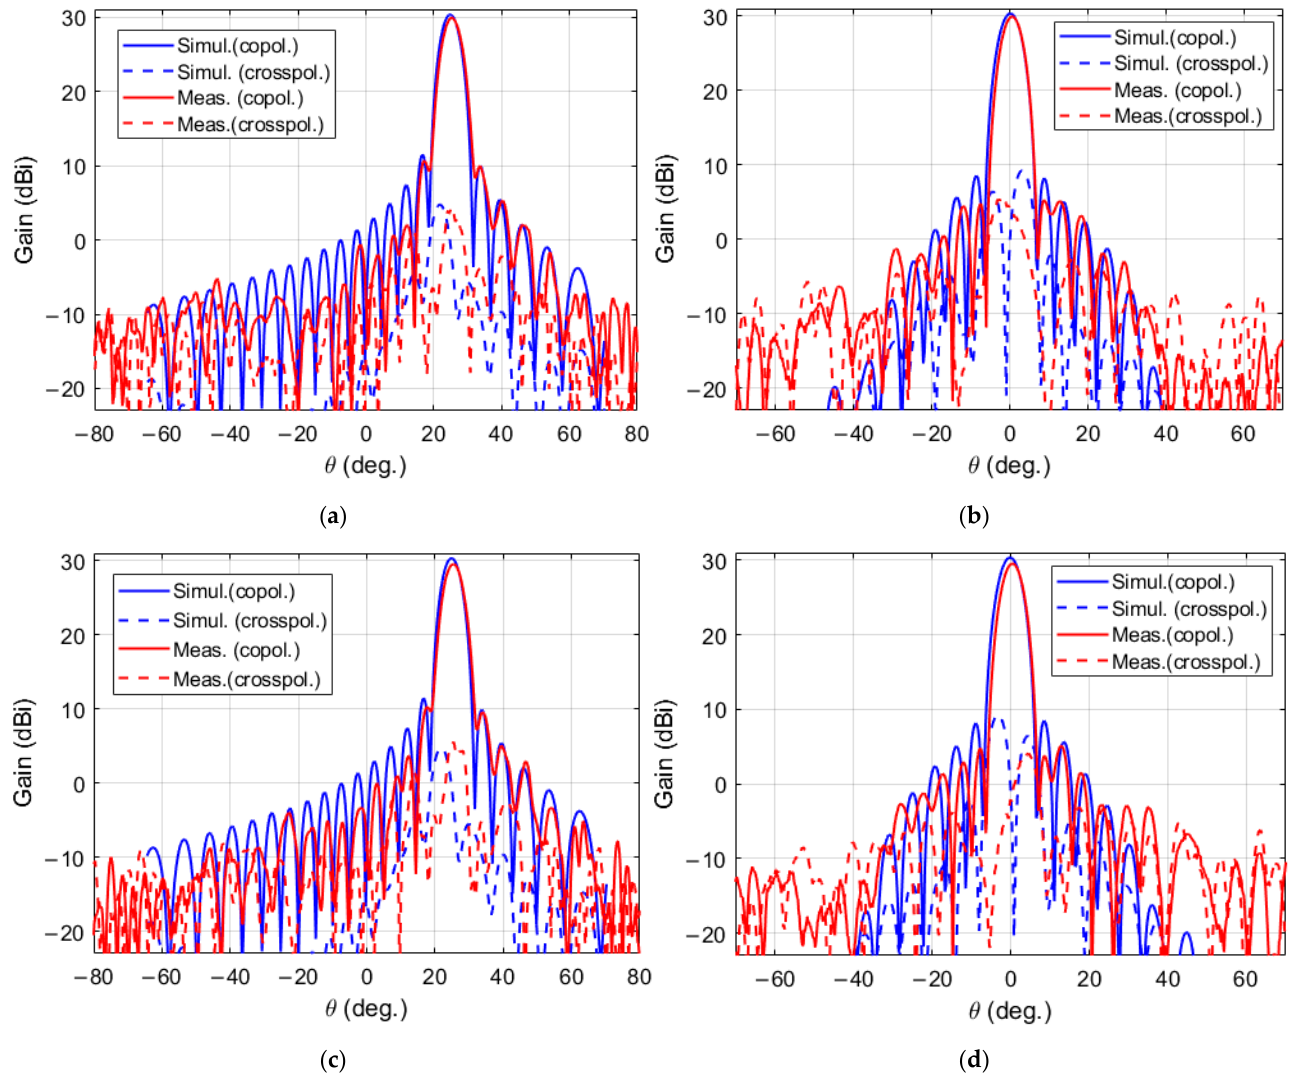
Figure 8. Comparison of simulated and measured radiation patterns at 19.7 GHz for the beam produced in RHCP ( a ) in the xz -plane and ( b ) in the azimuth plane, and for the beam produced in LHCP ( c ) in the xz -plane and ( d ) in the azimuth plane.